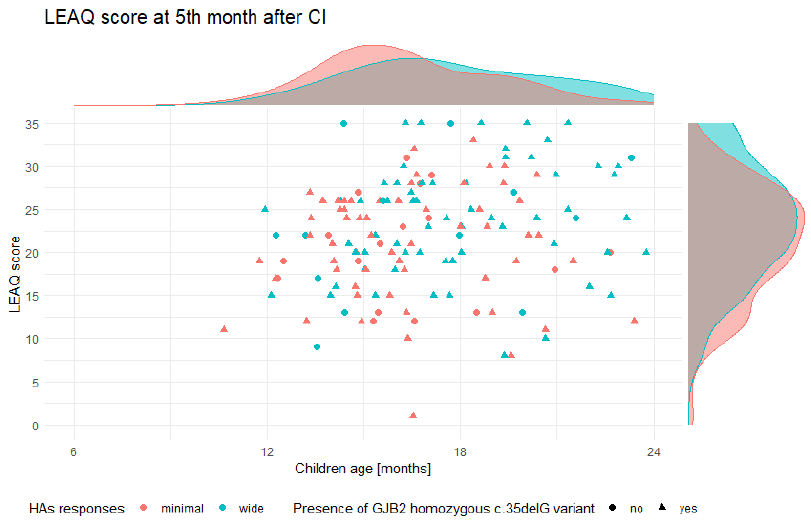
Figure 4. Distribution of LEAQ scores in the fifth month after CI in DFNB1 HL patients. In the ninth month after CI, there were no statistically significant differences in mean LEAQ score (LEAQ_9) between the studied groups of children. All implanted DFNB1 HL patients reached approximately 28 points (data not shown).